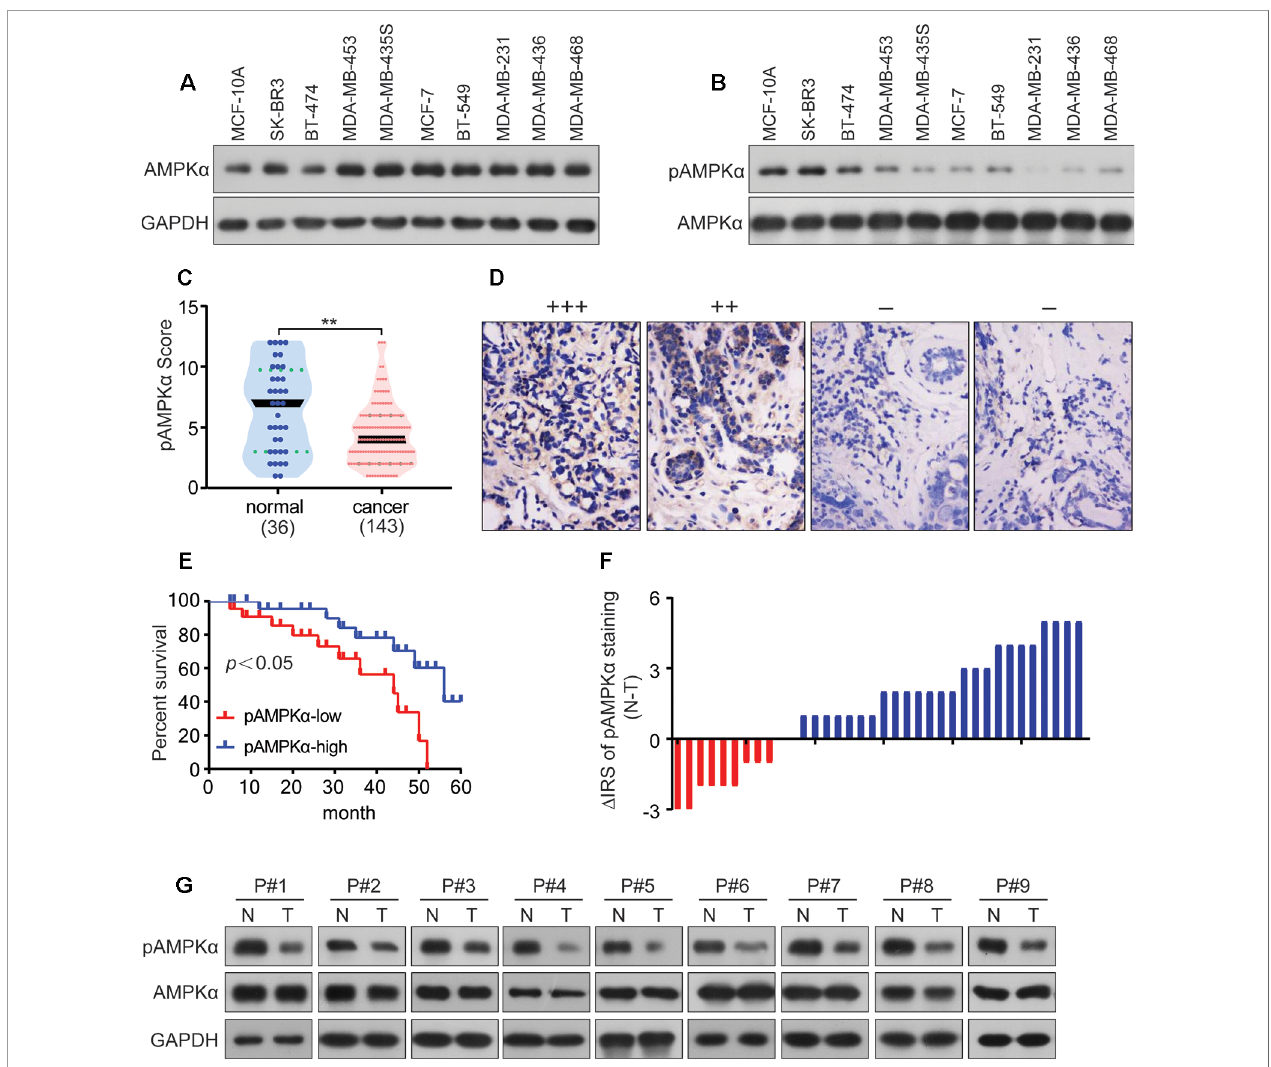
FIGURE 5 | AMPK a is low phosphorylated in BC and correlates with clinicopathological parameters. (A , B) : Western blot analysis showed AMPK a expression and phosphorylation in different cell lines. (C) : Immunohistochemistry analysis of AMPK a phosphorylation levels in BC specimens and normal tissues. ** P < 0.01. (D) : Representative immunohistochemical staining examples of AMPK a phosphorylation in BC tissues. (E) : Survival curves of BC patients with low phosphorylation versus high phosphorylation of AMPK a . (F): The distribution of the difference in AMPK a phosphorylation staining ( D IRS = IRSN − IRST). Immunoreactivity score (IRS) of AMPK a phosphorylation staining was available from 36 pairs of tissues; P values were calculated with the Wilcoxon test. AMPK a phosphorylation was lower in tumor tissues (T) compared with paired adjacent non-tumor tissues (N). IRST, IRS of tumor tissues; IRSN, IRS of non-tumor tissues. P < 0.05. (G) : The expression and phosphorylation of AMPK a in 9 human BC tumor tissues and adjacent non-tumor tissues (N) as tested by western blot